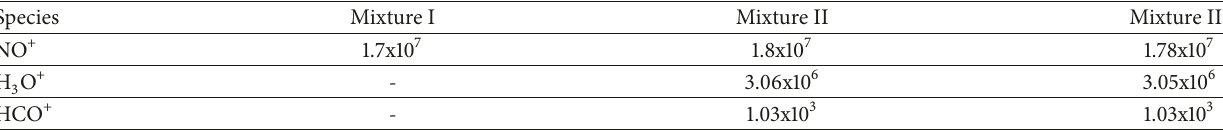
Table 3: Comparison of equilibrium concentrations of the dominant ions in mixtures